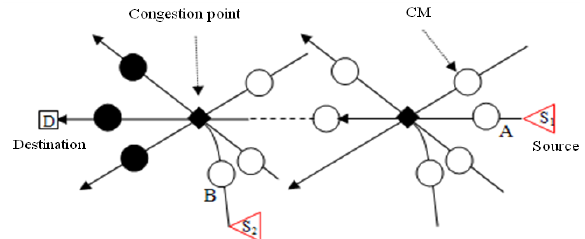
Fig. 6. The violation of a trustful source node in multiple